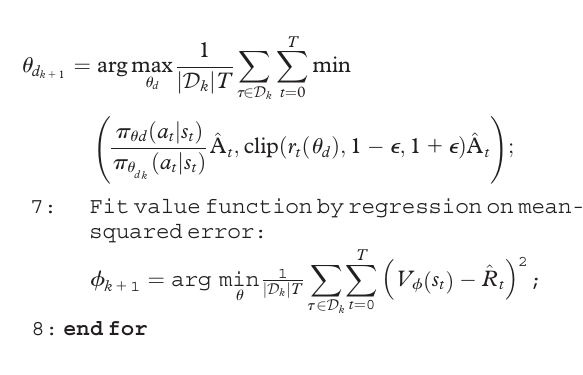
Algorithm 1 Hybrid Proximal policy optimization